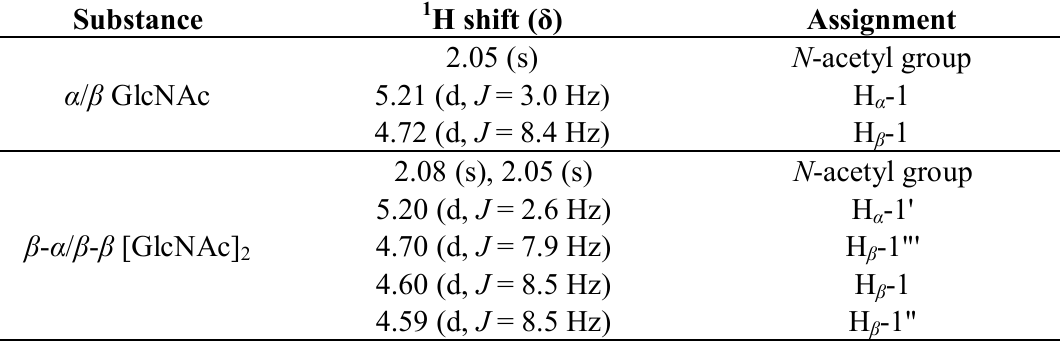
Table 1. The target 1 H-NMR chemical shifts of GlcNAc and (GlcNAc)